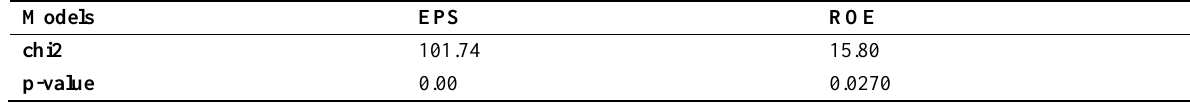
Table 7: Summary of Wald test for Heteroskedasticity in Fixed